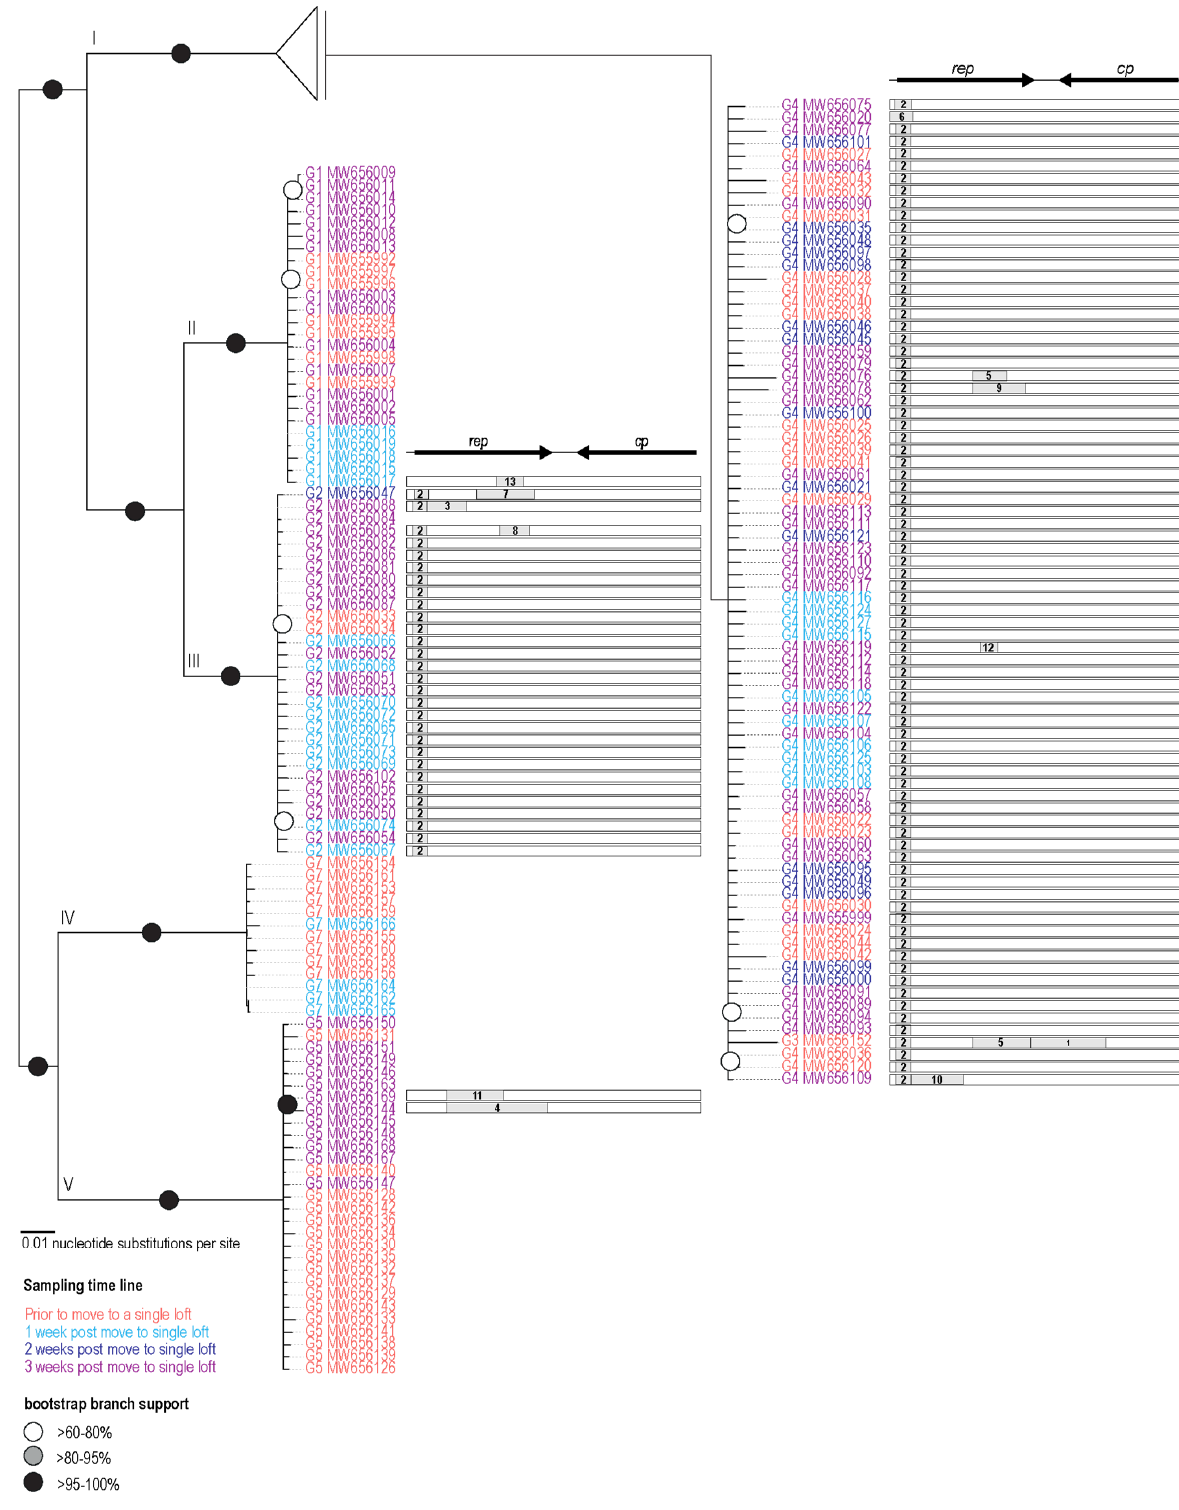
Figure 4. Maximum Likelihood phylogenetic tree of PiCV sequences recovered from study with recombinant regions removed. Recombinant regions identified in the genomes are shown next to the accession numbers. The five main clades are labeled in roman numerals (I–V). Genotypes (G1–G7) are labeled next to all the accession numbers.